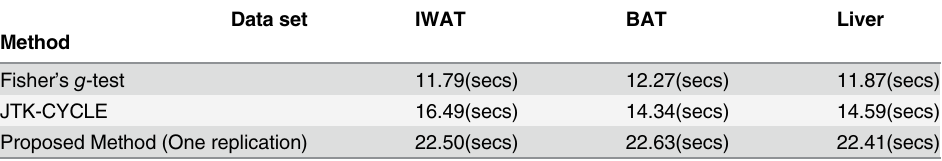
Table 3. IWAT, BAT and Liver data sets: timings (seconds) for Fisher ’ s g -test, Permutation test, JTK-CYCLE, and the proposed method on one bootstrap replication.